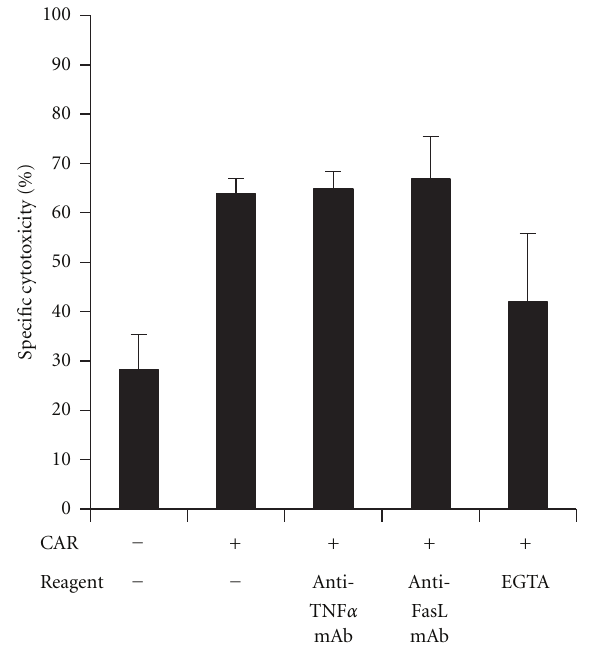
Figure 2: CAR-redirected T cells eliminate B-CLL cells pre- dominantly via granule-mediated cytolysis. Anti-CD19scFv-CD3 ζ CAR T cells were co-incubated (1 × 10 5 cells/well) with B-CLL cells (5 × 10 5 cells/well) in presence of the blocking anti-Fas- ligand antibody (10 μ g/mL), the neutralizing anti-TNF α antibody (10 μ g/mL), and EGTA (2mM), respectively. Viability of B-CLL cells was monitored by flow cytometry after 18hrs. As controls, the neutralizing capacities of the anti-TNF- α and anti-FasL antibodies were assessed by incubation of sensitive indicator cells with the respective reagents and antibodies in a cytotoxicity assay (data not